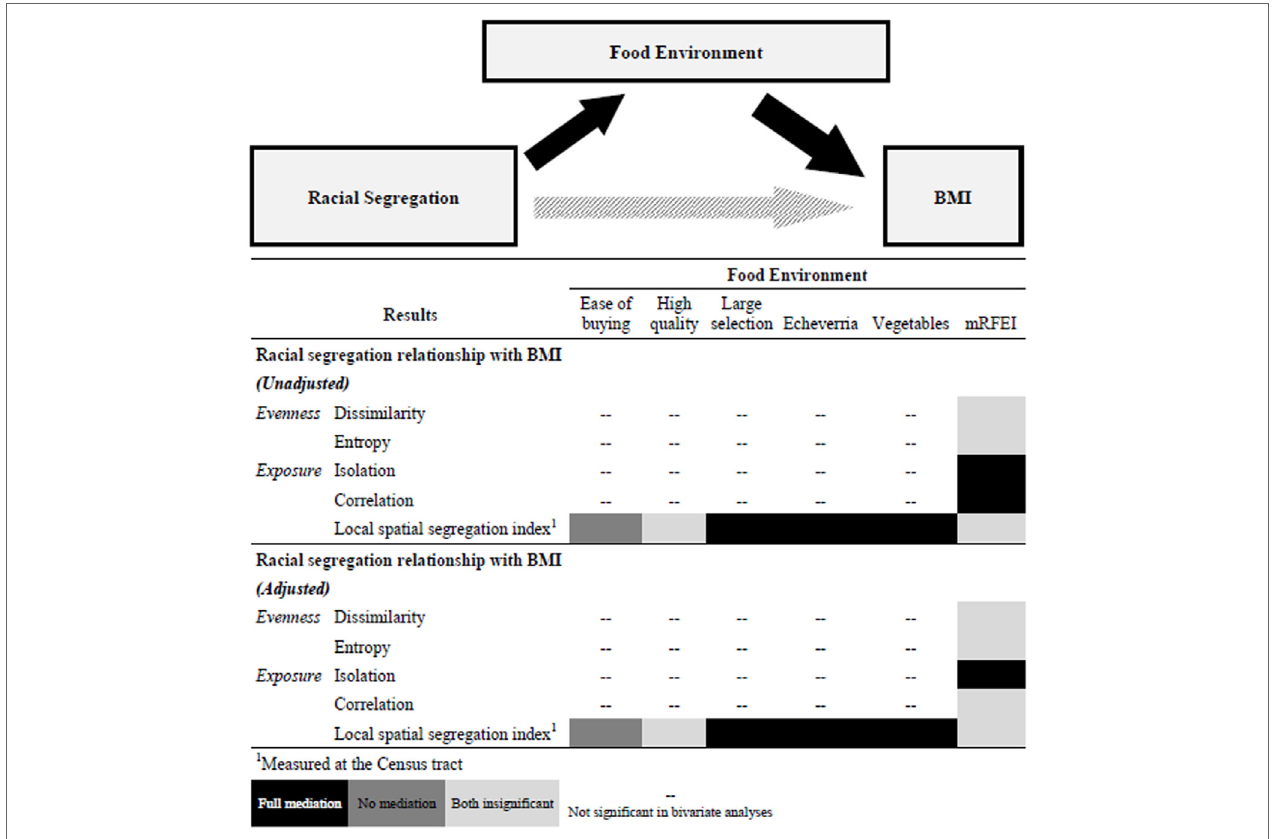
FigUre 2 | Mediation pathway and Gantt chart summary of results. Note: mRFEI is the modified retail food environment index; a higher score indicates a higher percentage of healthful-food vendors. Easy of buying is easy to by fresh produce. High quality is high quality of produce. Large selection is large selection of produce. Echeverria is the modified access to health foods subscale. Vegetables is daily intake of